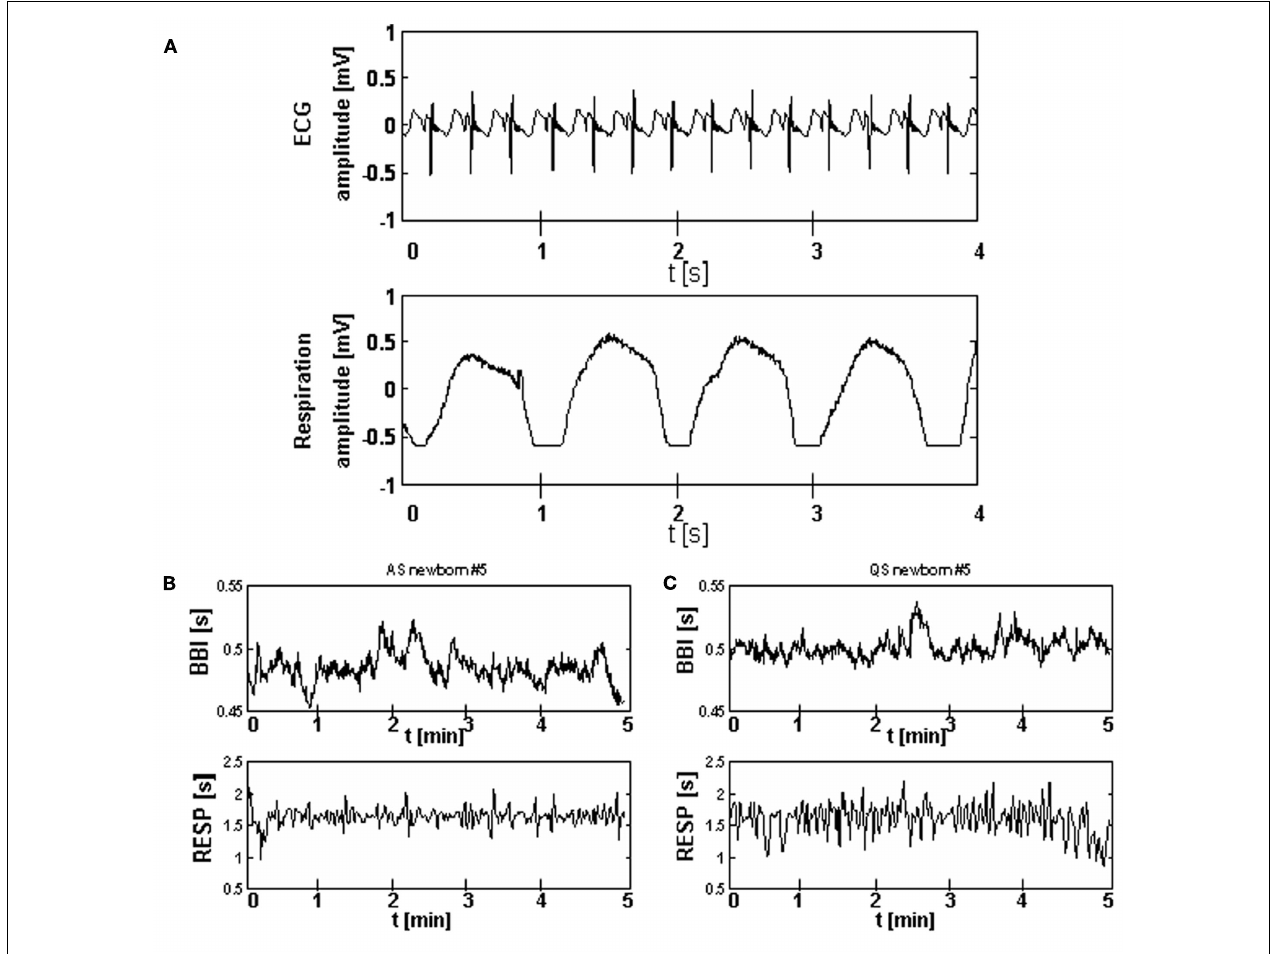
FIGURE 1 | Examples of a ECG and a respiration signal from one preterm newborn (A) and of BBI and RESP time series for active sleep (B) and quiet sleep (C)